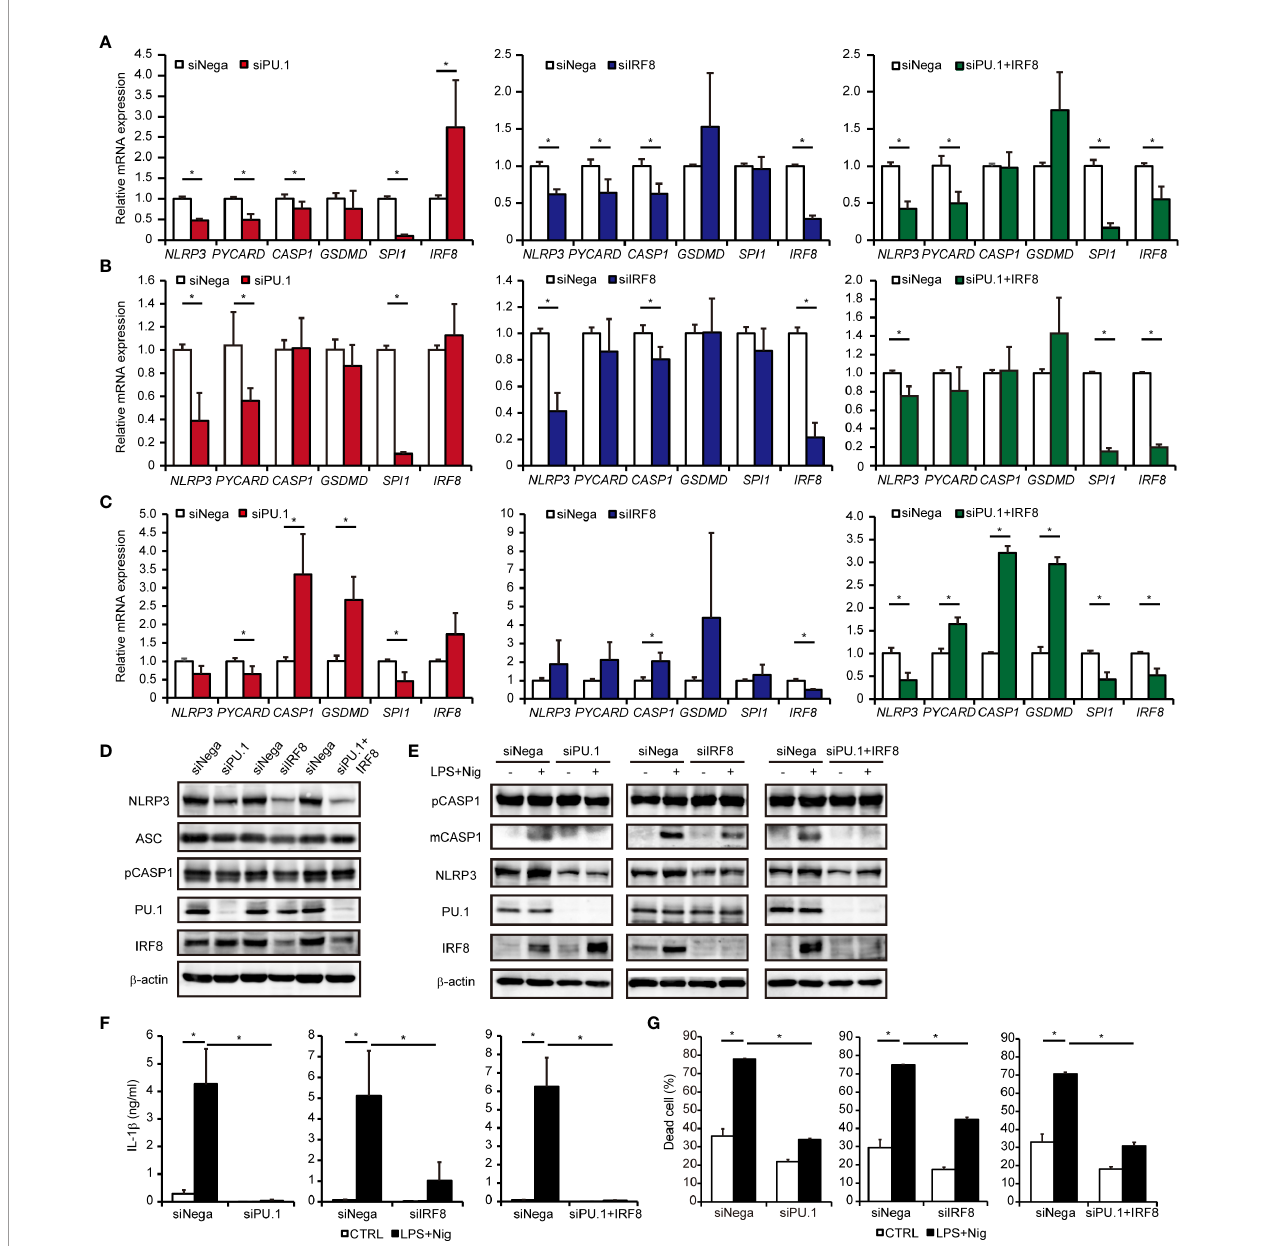
FIGURE 5 | Effects of PU.1 and IRF8 knockdown on NLRP3 expression and activation of the NLRP3 in fl ammasome in human macrophages. (A – D) THP-1 (A, D) , U937 (B) , or human macrophages (C) were transfected with SPI1 siRNA (siPU.1), IRF8 siRNA (siIRF8), or negative control siRNA (siNega) and incubated for 48 h. (A – C) Relative mRNA expression was determined by qPCR and normalized to expression of Gapdh mRNA. (D) Cellular protein expression was determined by western blotting. (E – G) THP-1 cells were differentiated into macrophages by stimulating with 25 ng/mL PMA for 3 h and incubation for 21 h. Cells were primed with 1 m g/mL LPS for 4 h and then stimulated with 10 m M nigericin for 0.5 h (E, F) or 2 h (G) . (E) Cellular protein expression was determined by western blotting. (F) Amount of IL-1 b in the culture medium was measured by ELISA. (G) Rate of dead cells was determined by fl ow cytometry. Data are presented as the mean + S.D. ( n = 3). (A – C) * p < 0.05, two-tailed student ’ s t -test analysis. (F, G) * p < 0.05, Tukey – Kramer